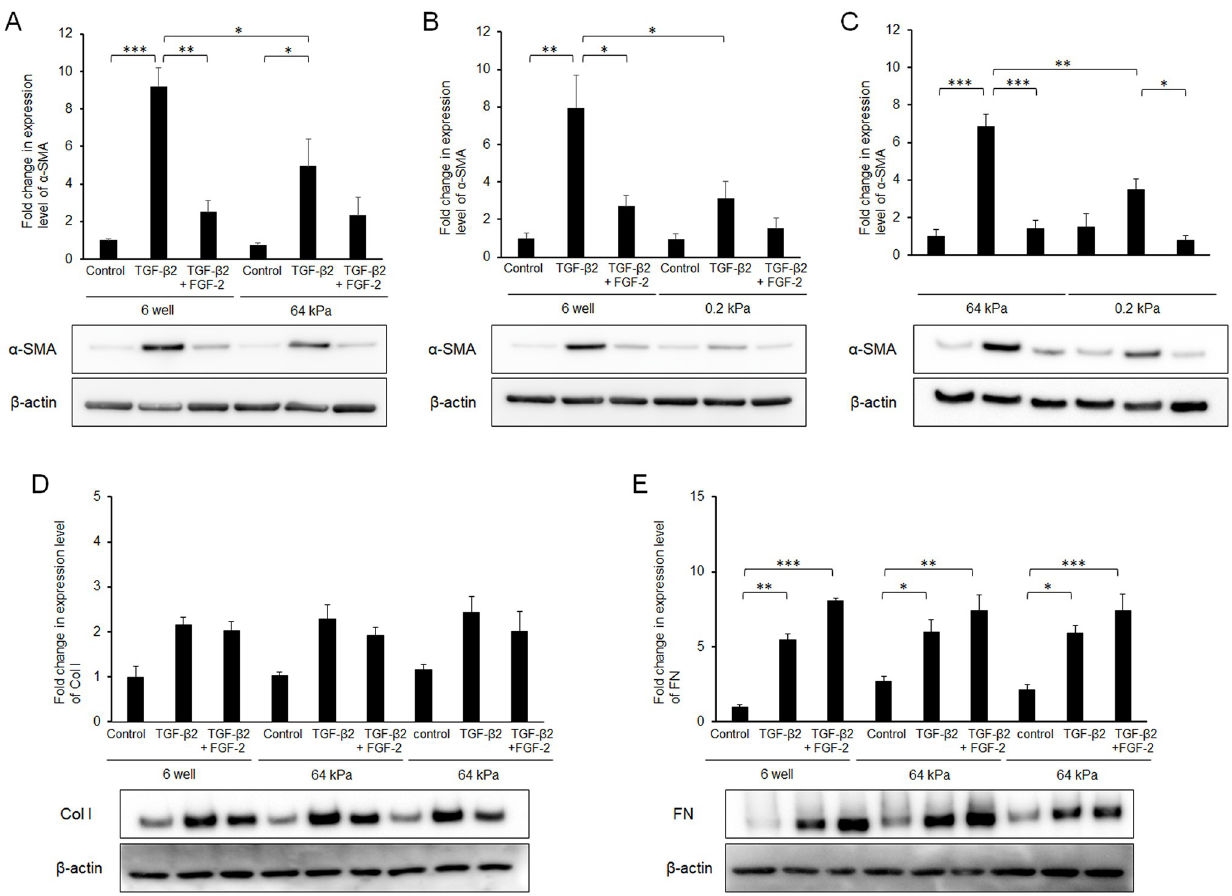
Fig 5. Effects of FGF-2 and/or a soft substratum on TGF- β -induced expression of α -SMA. Conjunctival fibroblasts were cultured on normal plastic wells or soft substratum wells (64 or 0.2 kPa), and treated with FGF-2 (10 ng/mL) and/or TGF- β 2 (2.5 ng/mL) for 48 h, followed by Western blot analysis. The induction of α -SMA by TGF- β 2 was decreased on a soft substratum in the softness-dependent manner. FGF-2 suppressed TGF- β -induced α -SMA expression even on the soft substratum. � p < 0.05. Data are shown as the mean ± SE, n = 3.